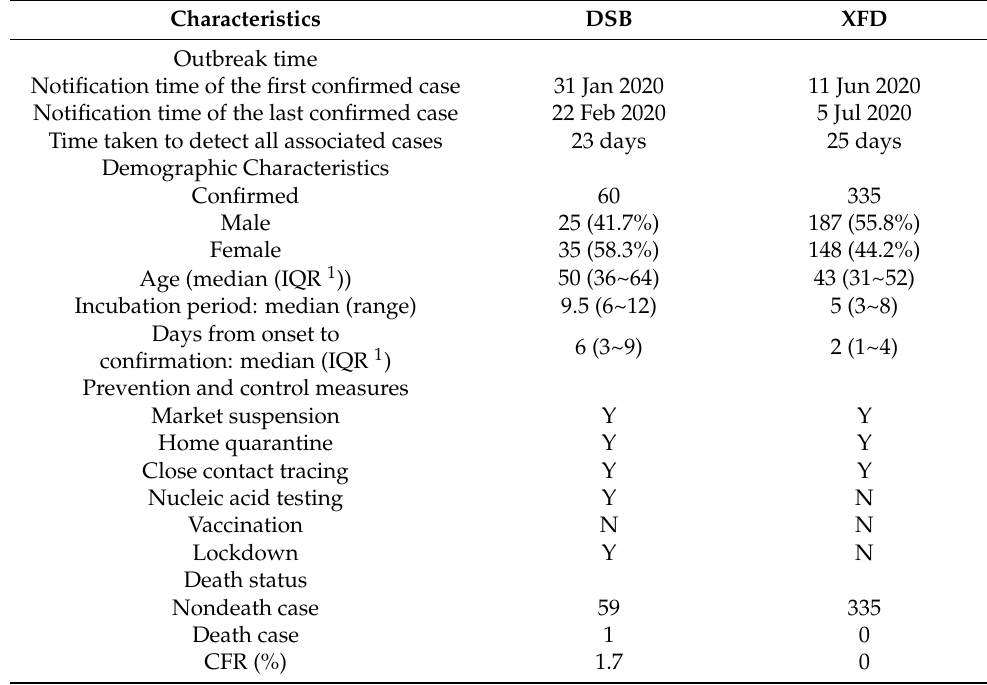
Table 1. Characteristics of DSB and XFD outbreaks in clusters. Characteristics DSB